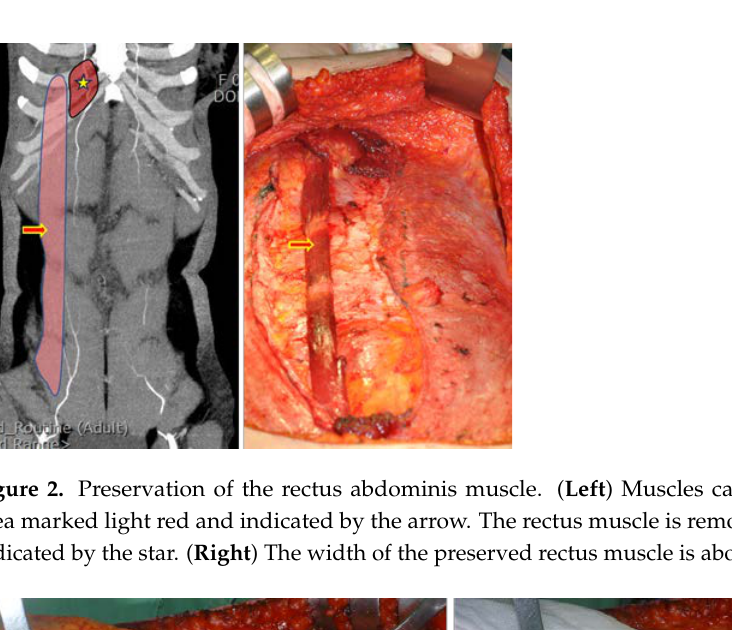
Figure 2. Preservation of the rectus abdominis muscle. ( Left ) Muscles can be preserved in the area marked light red and indicated by the arrow. The rectus muscle is removed from the red area indi- cated by the star. ( Right ) The width of the preserved rectus muscle is about 2–3 cm.